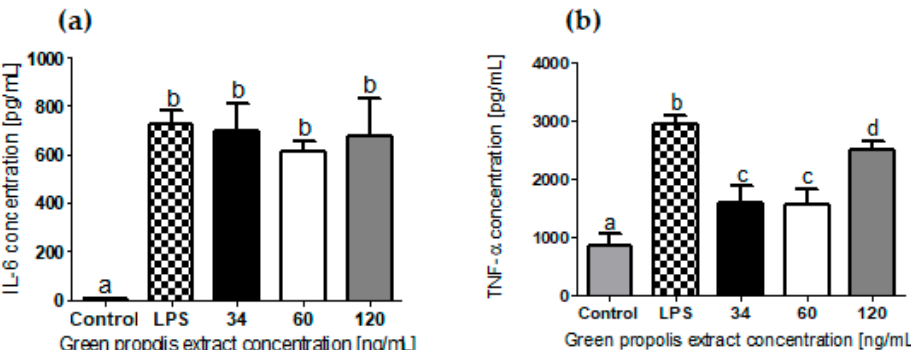
Figure 2. Modulation of IL-6 ( a ) and TNF- α ( b ) expression by macrophages (AMJ-2) after stimulation with LPS and treatment with green propolis extract containing artepillin C in a concentration range of 4 to 14 ng/mL. Equal letters indicate statistical similarity while different letters indicate statistical difference (ANOVA with Tukey’s post hoc test, p < 0.05) ( n = 6).